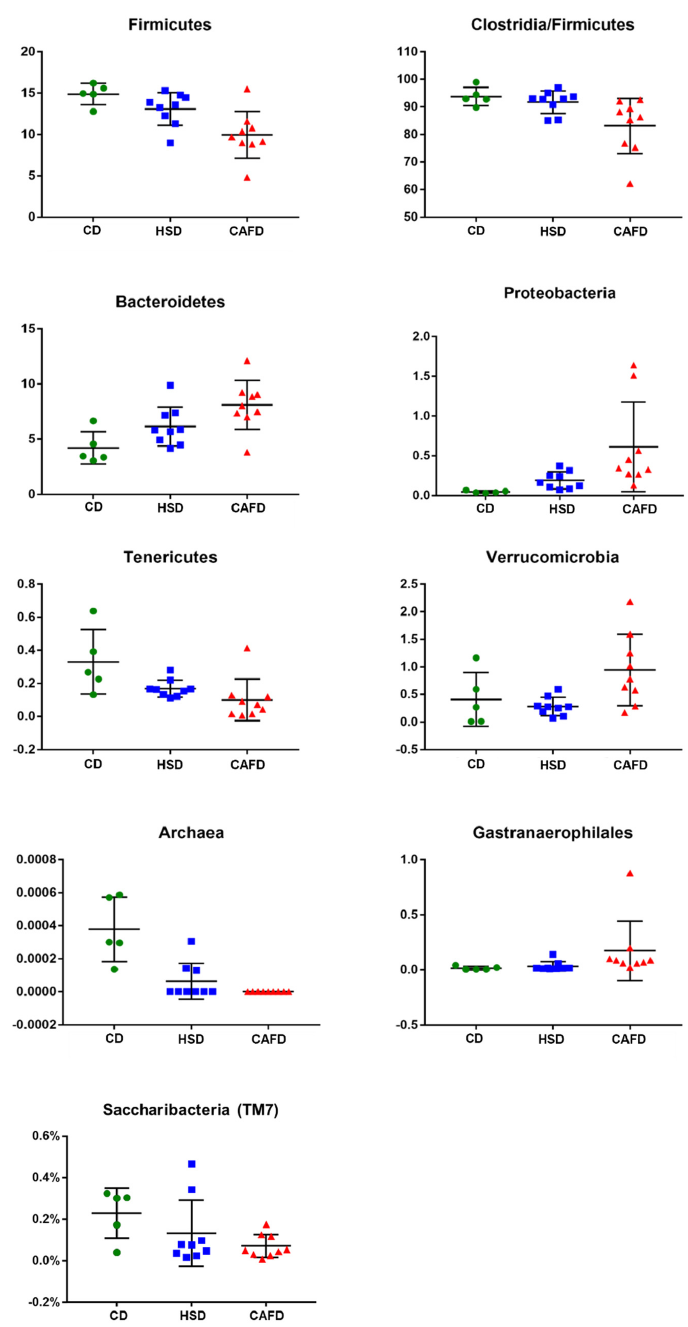
Figure 3. Graphical representation of the effects of different diets on taxa frequencies of the most representative taxa in samples collected from male Wistar rats fed with chow diet (CD) (n = 5), high-sugar (HSD) (n = 9) or cafeteria diet (CAFD) (n = 9) for 14 weeks. Values are expressed in percentage and represent mean ± SD.